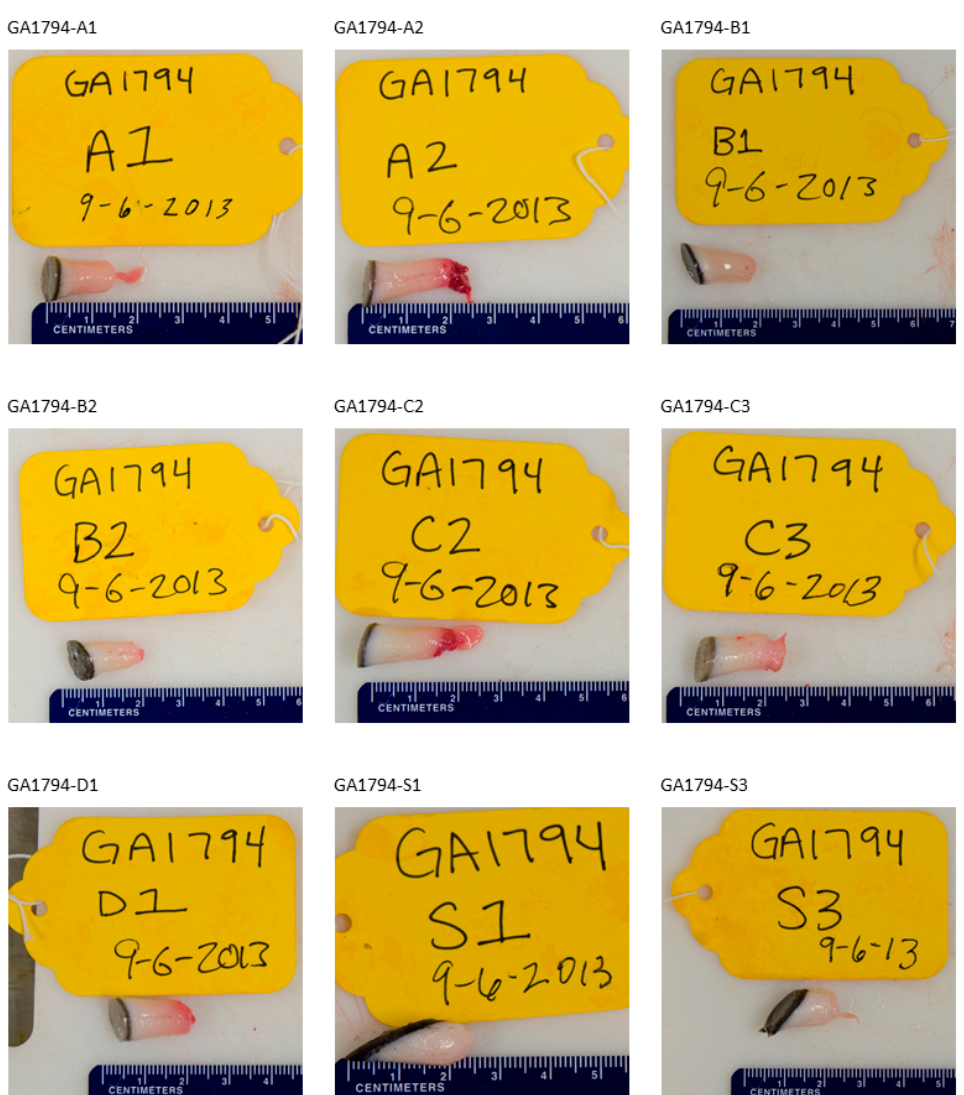
Figure 7. Example of samples obtained from each grid partition from carcass GA1794. Compare samples to the gross description of wounds in Table 2. Samples A1, A2, B1, and B2 were associated with skeletal impacts. Samples C2 and C3 over-penetrated into muscle 15 and 20 mm beyond the blubber layer, respectively. Samples D1, S1, and S3 were described as having minimal or no visible subdermal effect on the carcass.